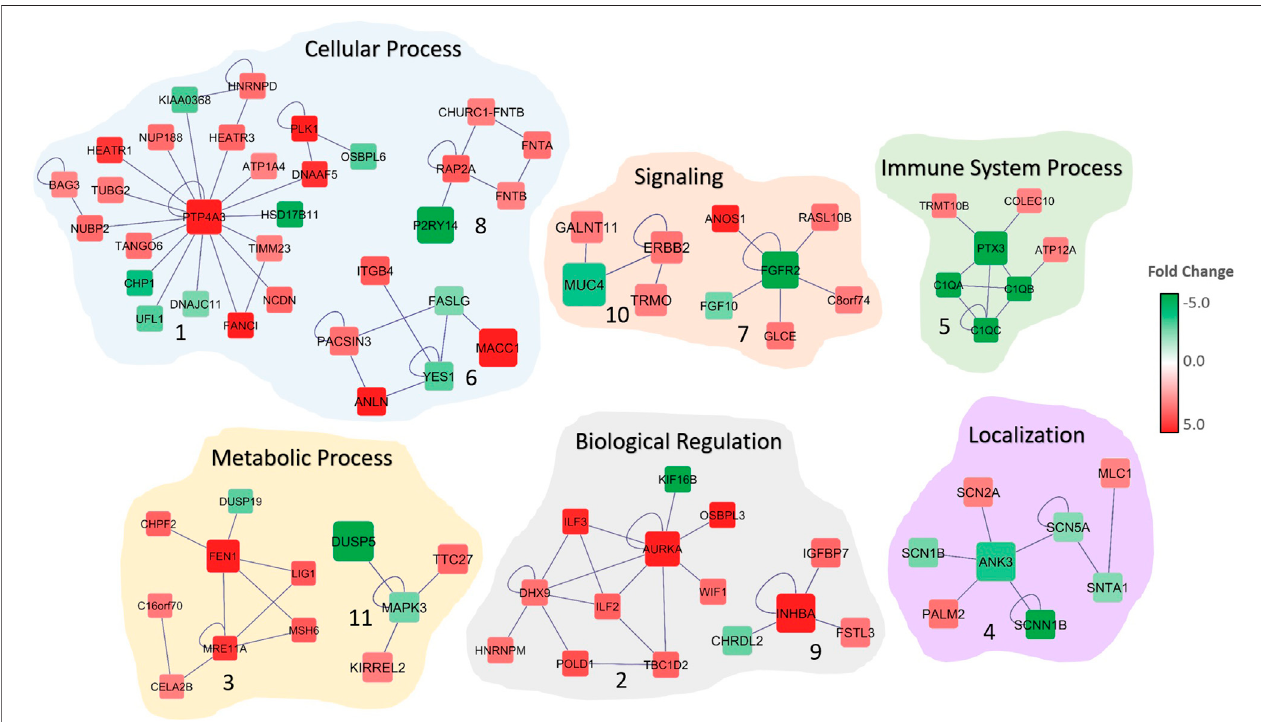
FIGURE 2 | Signi fi cant subnetworks associated with colorectal cancer. The color of each gene scales with the fold-change in gene expression in CRC patients compared to normal. Up-regulated genes are indicated in red and down-regulated genes in green. Edges represent the interactions. Biological processes that are associated with the subnetworks are shown.